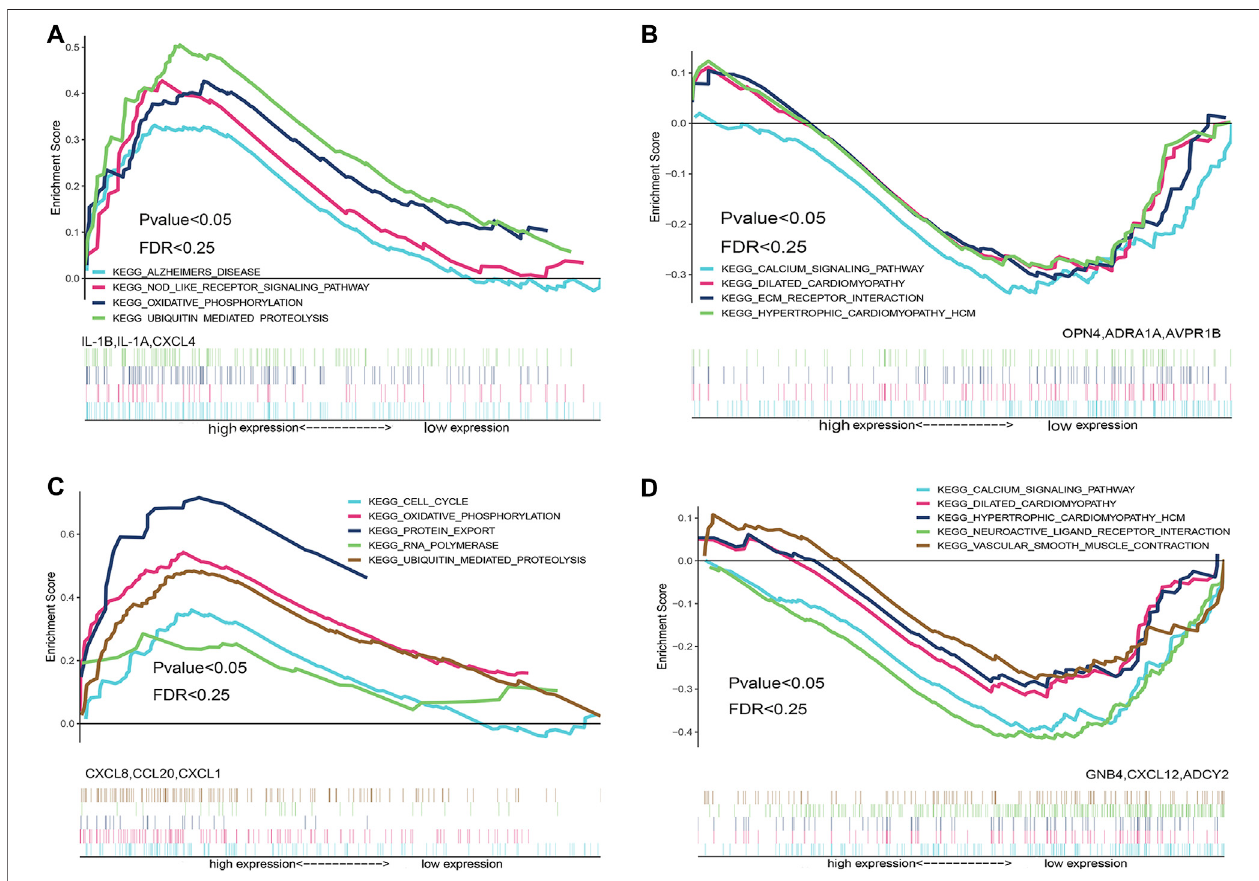
FIGURE 6 | Gene set enrichment analysis (GSEA) enrichment analysis based on the hub gene. GSEA enrichment analysis was performed based on differentially down-regulated hub genes ( Figure 6A ), and GSEA enrichment analysis was performed based on differentially up-regulated hub genes ( Figure 6B ). GSEA enrichment analysis was performed on hub genes that were down-regulated after the intersection of miRNA target genes and differential genes ( Figure 6C ), and GSEA enrichment analysis was performed on the hub genes that were up-regulated after the intersection of miRNA target genes and differential genes ( Figure 6D ).